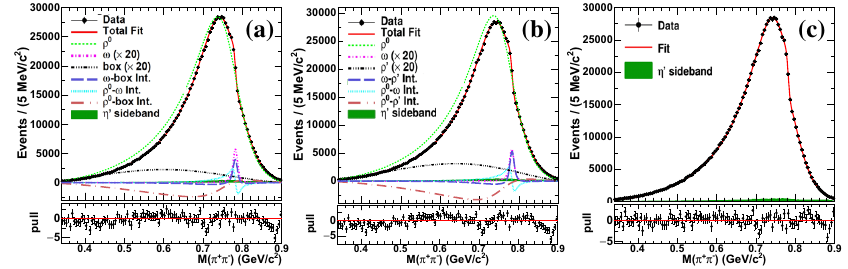
Figure 3. (a) Model-dependent fit results in case ρ 0 - ω -box anomaly; (b) model-dependent fit results in case ρ 0 - ω - ρ (cid:3) ; (c)model-independent fit with ω interference. Dots with error bars represent data, the green shaded histograms are the background from η (cid:3) sideband events, the red solid curves are the total fit results, and others represent the separate contributions as